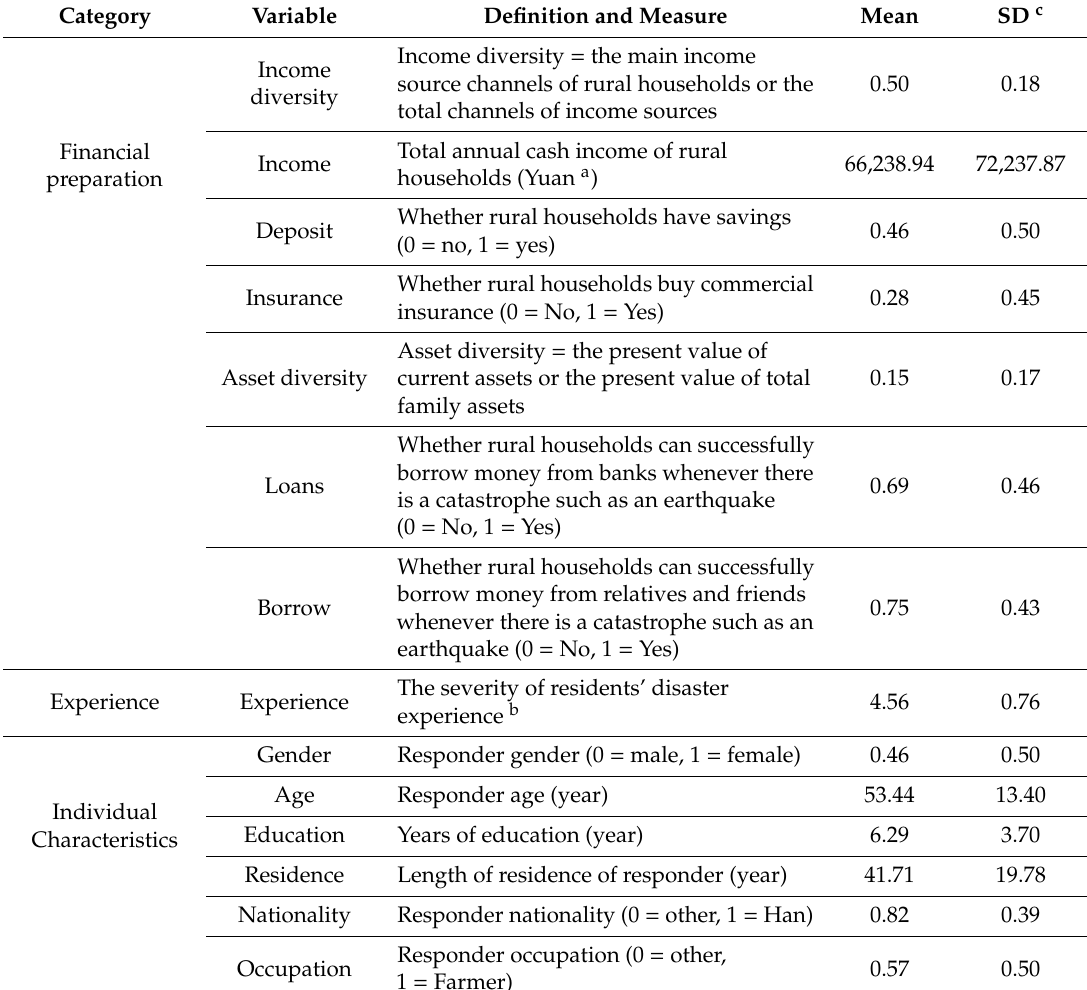
Table 3. Definition and descriptive statistics of the variables in the